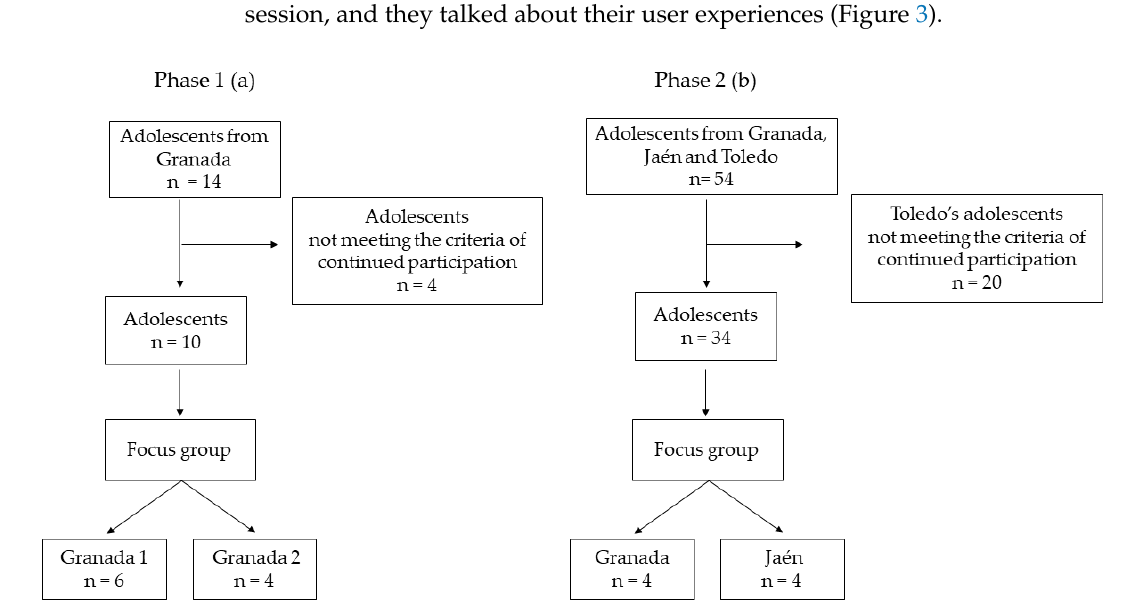
Figure 3. Flowchart of participants for phase 1 (plot a ) and phase 2 (plot b